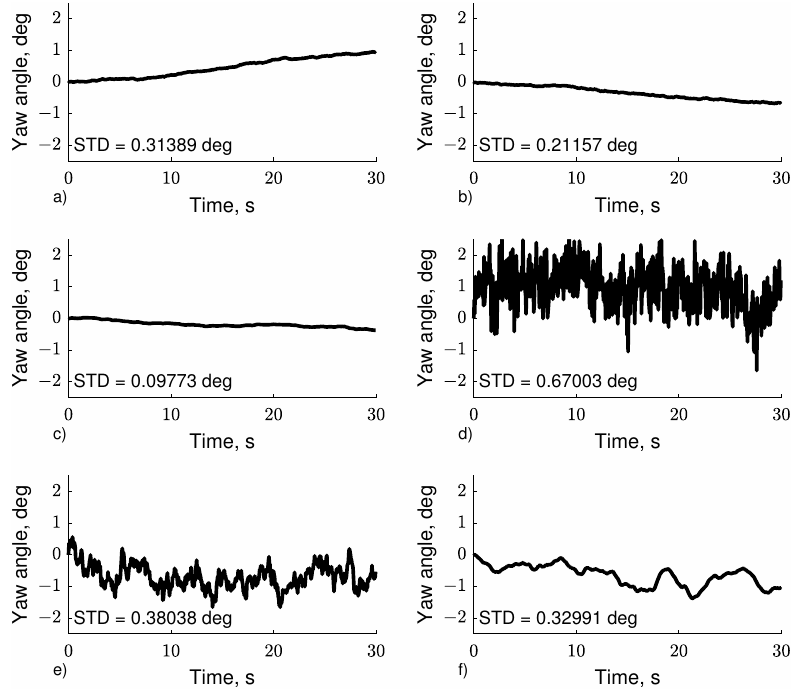
Figure 6. Yaw measurements for ( a ) Case 1, ( b ) Case 2, ( c ) Case 3, ( d ) Case 4, ( e ) Case 5, ( f ) Case 6.